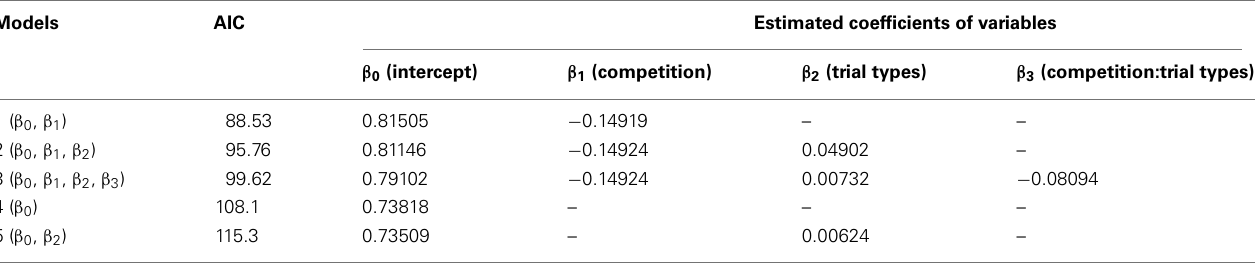
TableA2 | Peck latency (data shown in Figure 1C) was analyzed by generalized linear mixed model (GLMM) with log-link function.